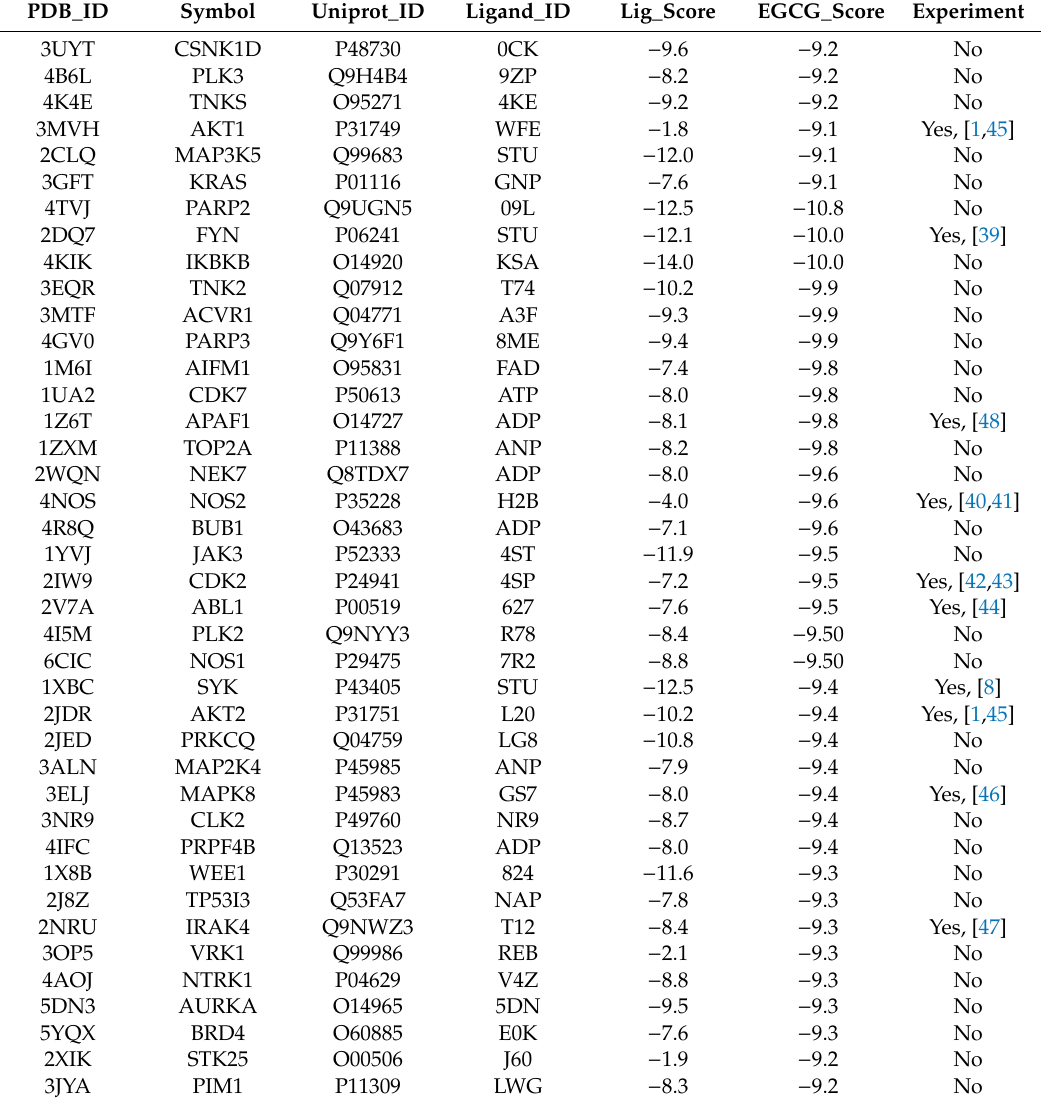
Table 1. The docking score of top 40 target proteins based on reverse